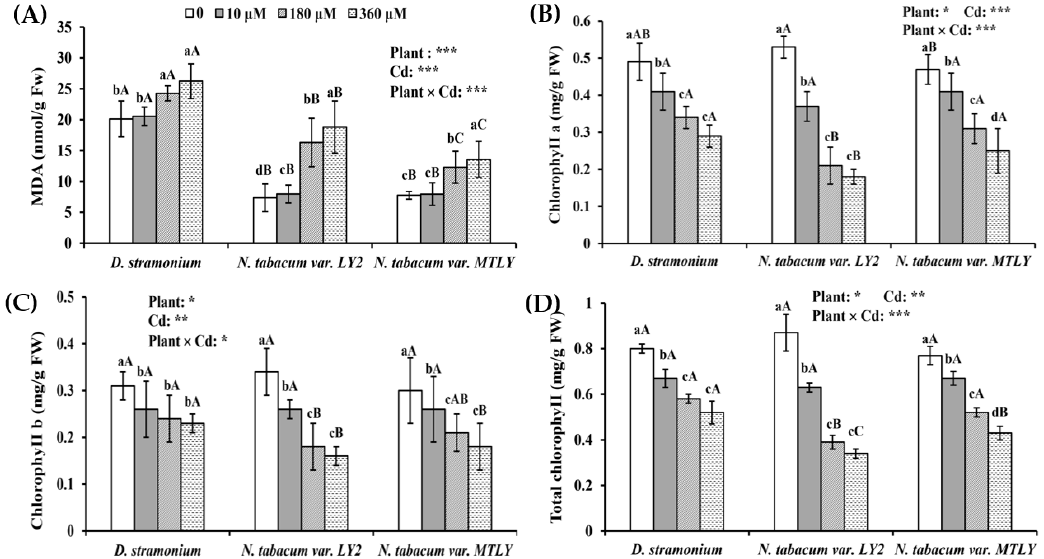
Figure 5. Cd-induced oxidative damage in seedlings. ( A ) Malondialdehyde (MDA) content in leaves. Contents of chlorophyll a ( B ), chlorophyll b ( C ) and total chlorophyll ( D ) in leaves. Values were expressed as means ± SD ( n = 9). Different lowercase letters on the bars indicated significant differences between the same material under different Cd concentrations. Different uppercase letters on the bars indicated significant differences between different materials under the same Cd treatment ( p < 0.05). GLM was used to assess the effects of plant materials, Cd treatments and their interactions on test results. The significance was indicated as follows: * 0.01 < p ≤ 0.05; ** 0.001 < p ≤ 0.01; *** p ≤ 0.001.